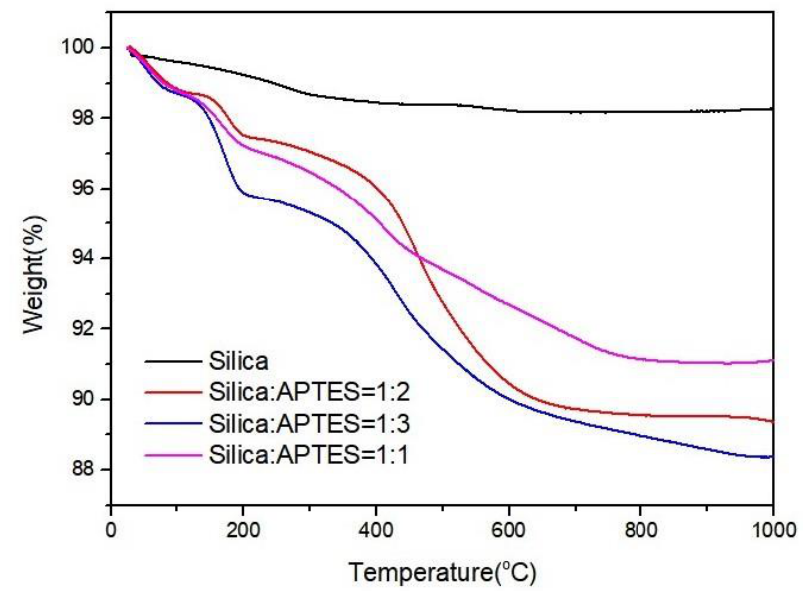
Figure 3. Thermogravimetric analysis (TGA) curves of APTES functionalized silica particles with different Si:APTES ratios.